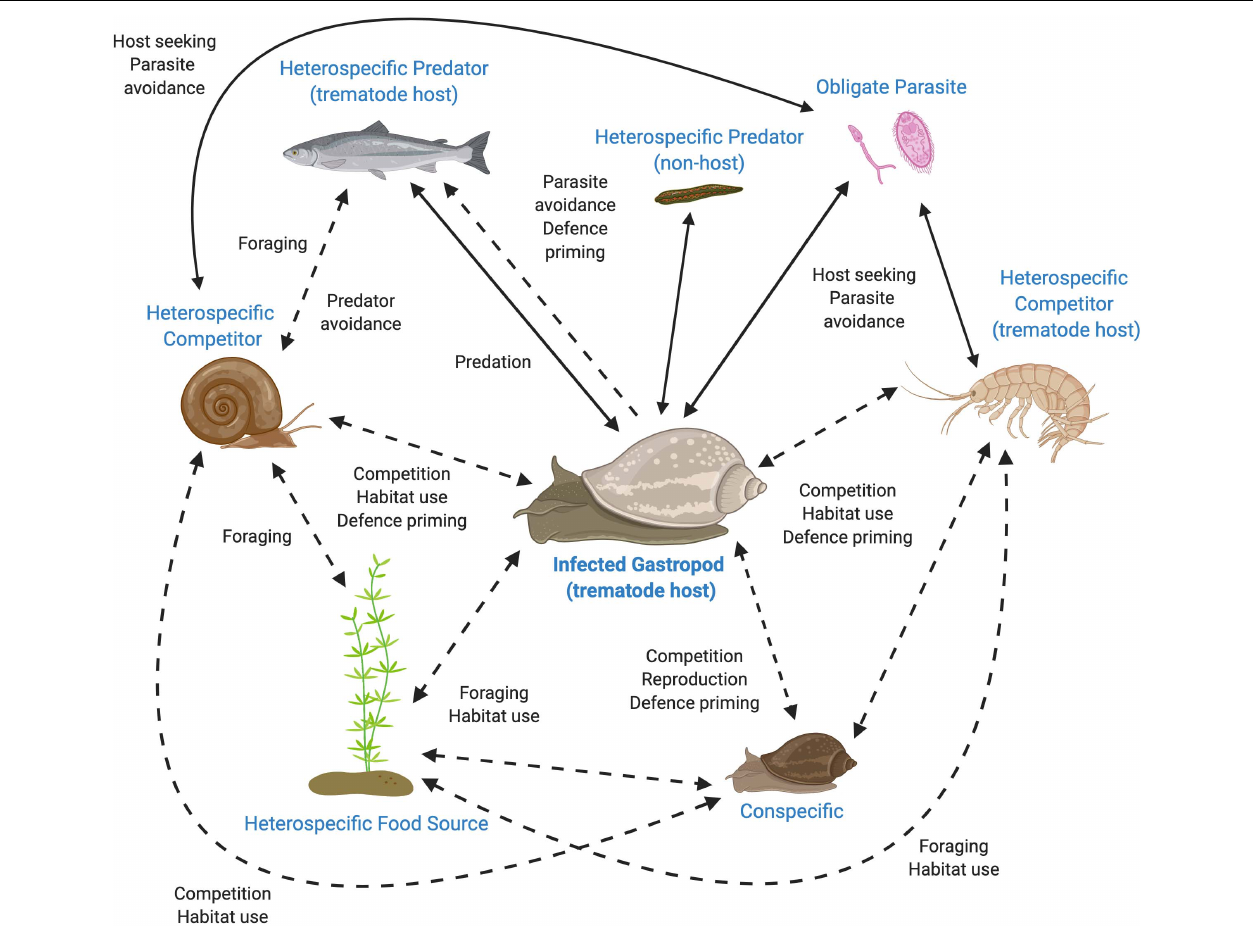
FIGURE 1 | Interactions in a freshwater community potentially mediated by chemical cues originating from a trematode-infected gastropod. Many of these interactions include non-consumptive effects of parasites that may be mediated by oxylipins [Dotted lines (and labels in bold)]. All interactions would be impacted by any change in the gastropod’s oxylipins, which would then have far reaching consequences for the surrounding community. Figure created with BioRender.com.